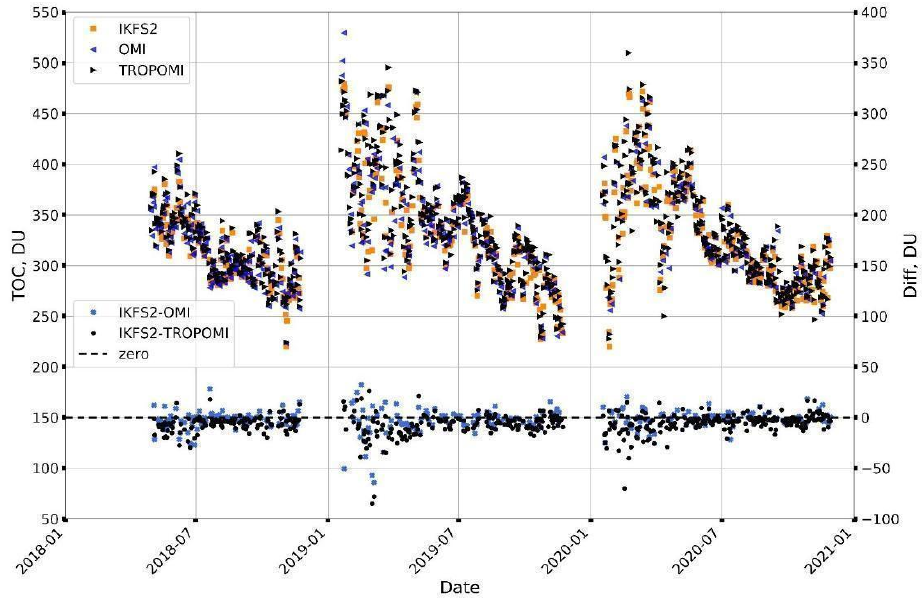
Figure 5. Time series of daily mean TOC near St. Petersburg in the 2018–2020 period according to the IKFS-2, OMI and TROPOMI satellite measurements (left scale) and their differences (right scale).